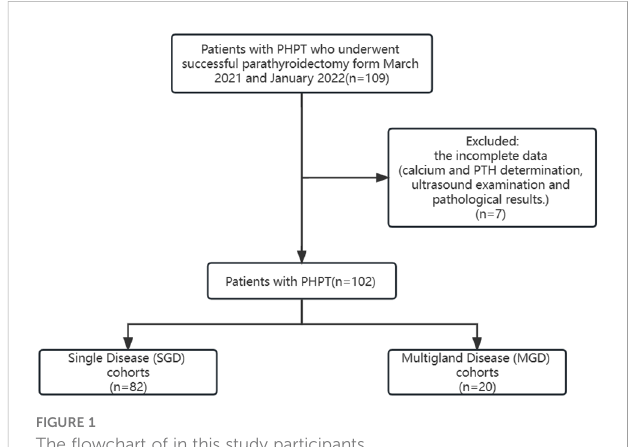
FIGURE 1 The fl owchart of in this study